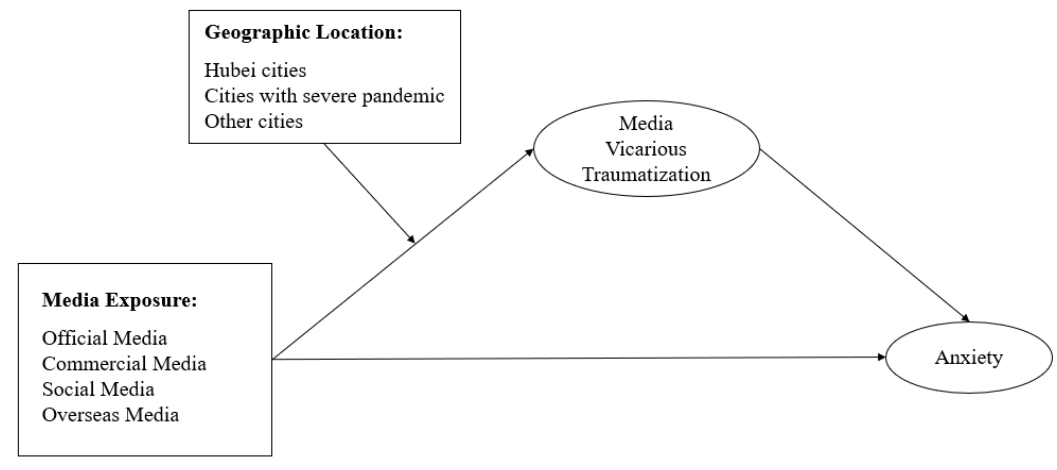
Figure 2. Conceptual framework.